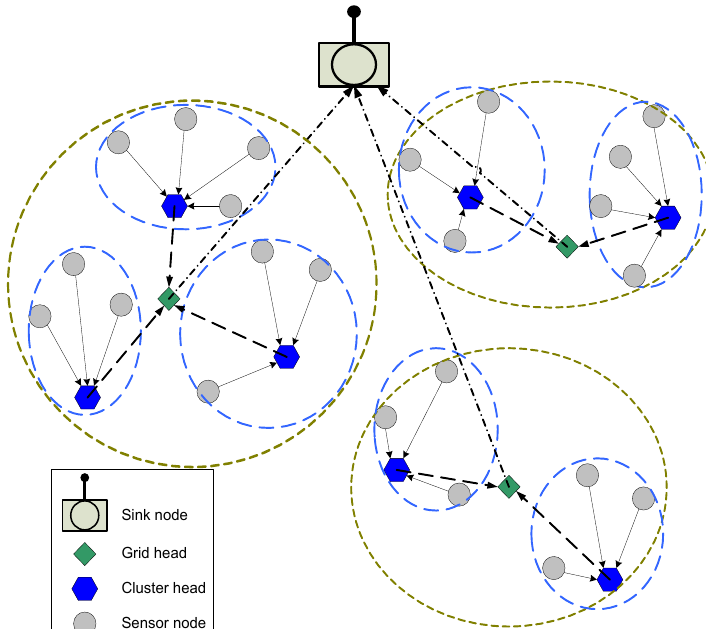
Figure 1. Three layer clustering